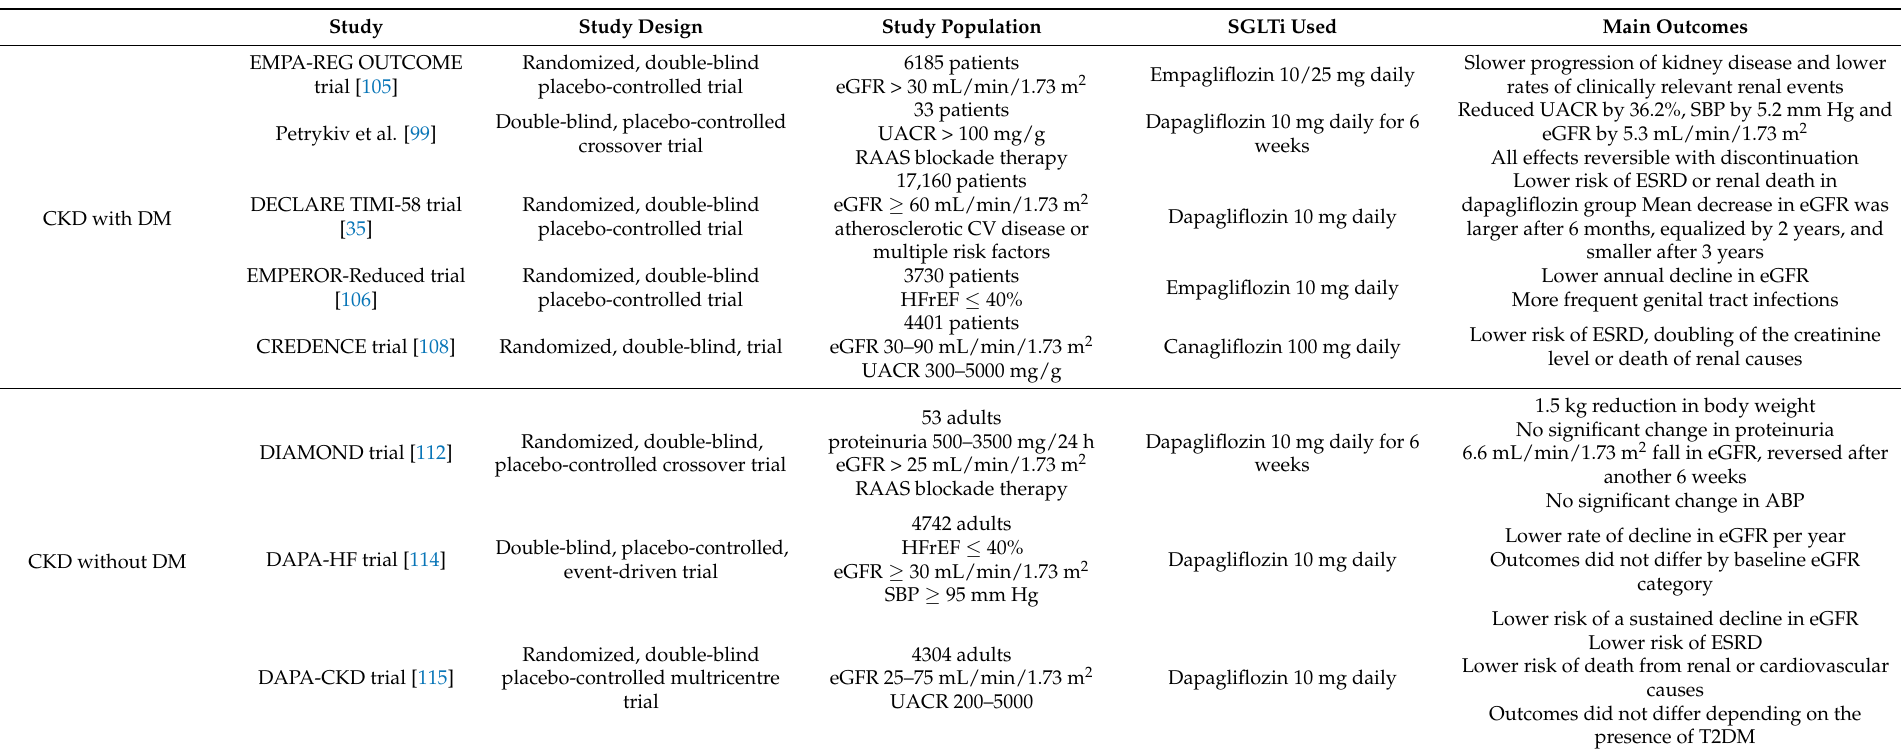
Table 1. Summary of clinical evidence concerning the role of SGLT2i in